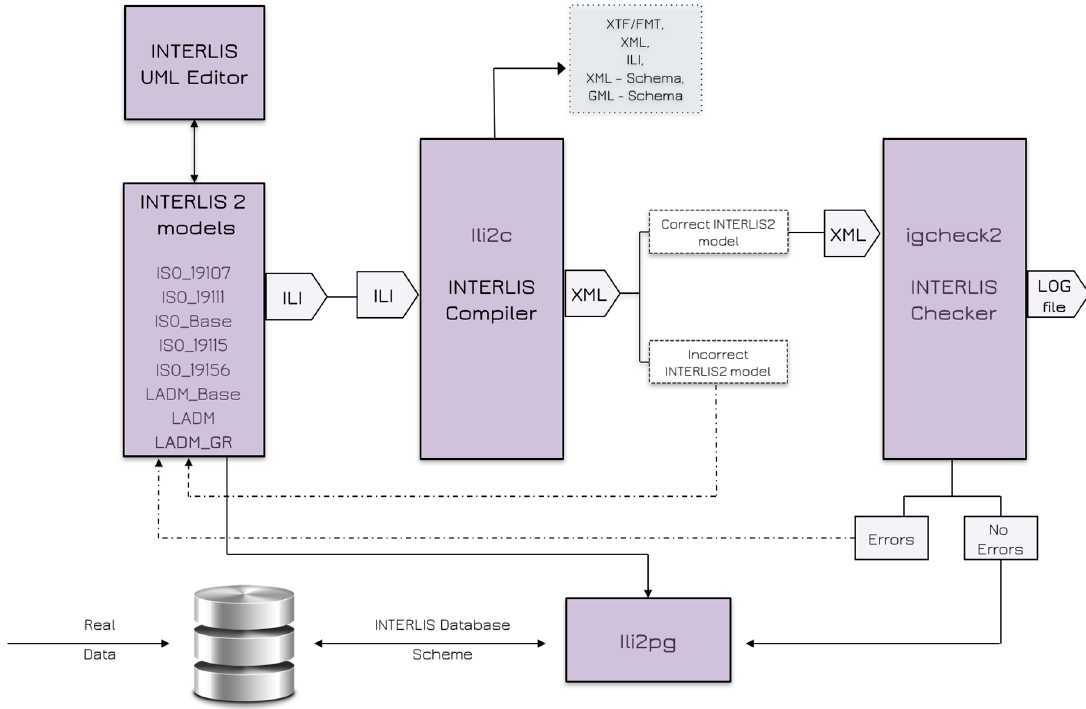
Figure 9. The LADM/INTERLIS approach developed and followed for the INTERLIS implementation in Greece ([8], edited).